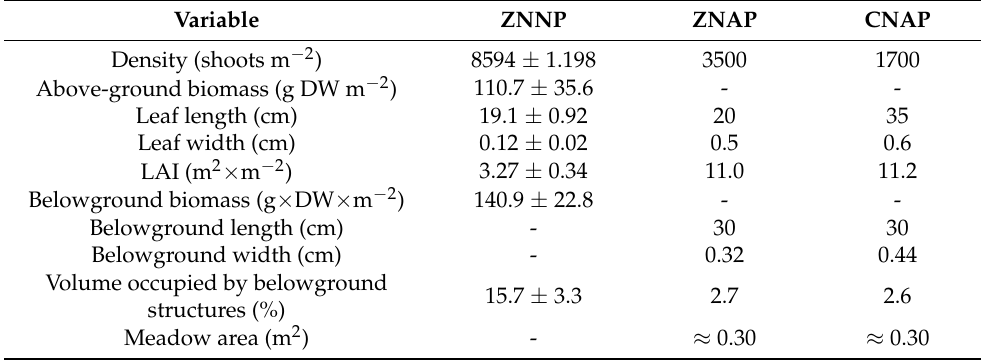
Figure 2. Scheme of the sampling procedure carried out. Fauna and sediment samples were collected following a spatial gradient parallel to the main flow direction. Mimics resembled the size and density of the two main species thriving in the area, Zostera noltei and Cymodocea nodosa . ZNAP, Zostera noltei artificial patches; CNAP, Cymodocea nodosa artificial patches. Table 1. Canopy and morphometric properties of Zostera noltei natural populations (ZNNP), and artificial patches of Z. noltei (ZNAP) and Cymodocea nodosa (CNAP). Values are mean ± SE. The percentage of volume occupied by the belowground biomass of Z. noltei was calculated through the biometric data collected on the rhizome-root system and considering that these structures are situated within the first 7.5 cm of the sediment